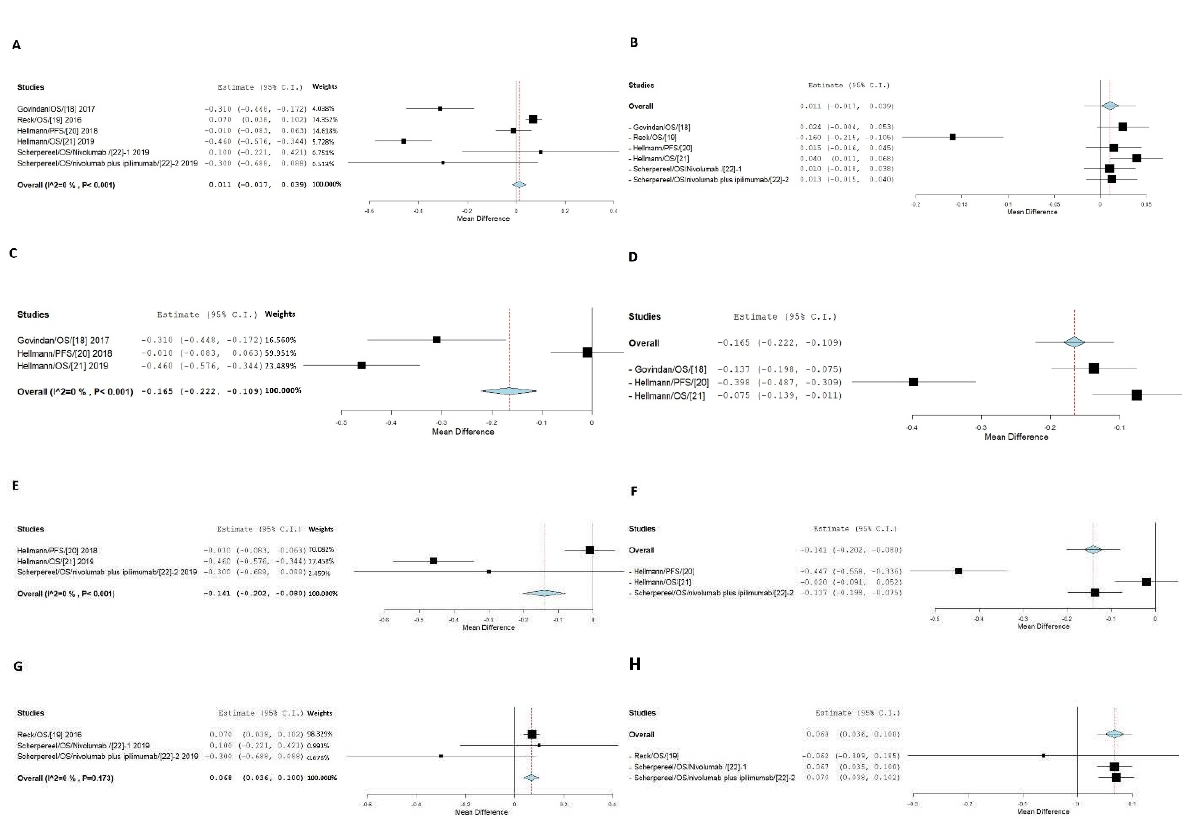
Figure 5. Meta-analysis of anti CTLA4 drugs on NSCLC and non-NSCLC between smokers and non-smokers. ( A ) Shows results of FE with all sets of data. ( B ) Shows results of FE with leave-one-out. ( C ) Shows results of FE with a subgroup of NSCLC patients. ( D ) Shows results of the FE model with leave-one-out for NSCLC patients. ( E ) Shows results of FE with a subgroup of combination between nivolumab and ipilimumab. ( F ) Shows results of the FE model with leave-one-out for combination between nivolumab and ipilimumab. ( G ) Shows the results of FE with non-NSCLC cancer or combination with other drugs. ( H ) Show the results of FE with leave-one-out for non-NSCLC or combination with other drugs.